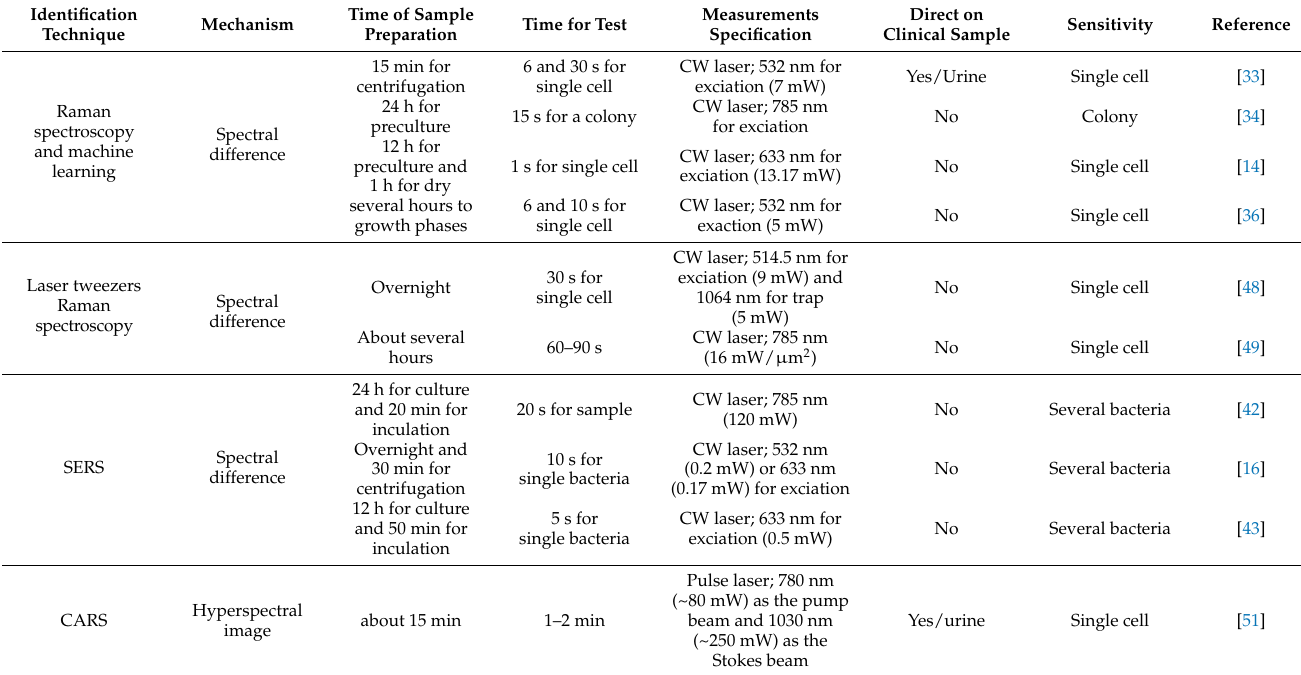
Table 1. Comparison of Raman-based bacterial identification